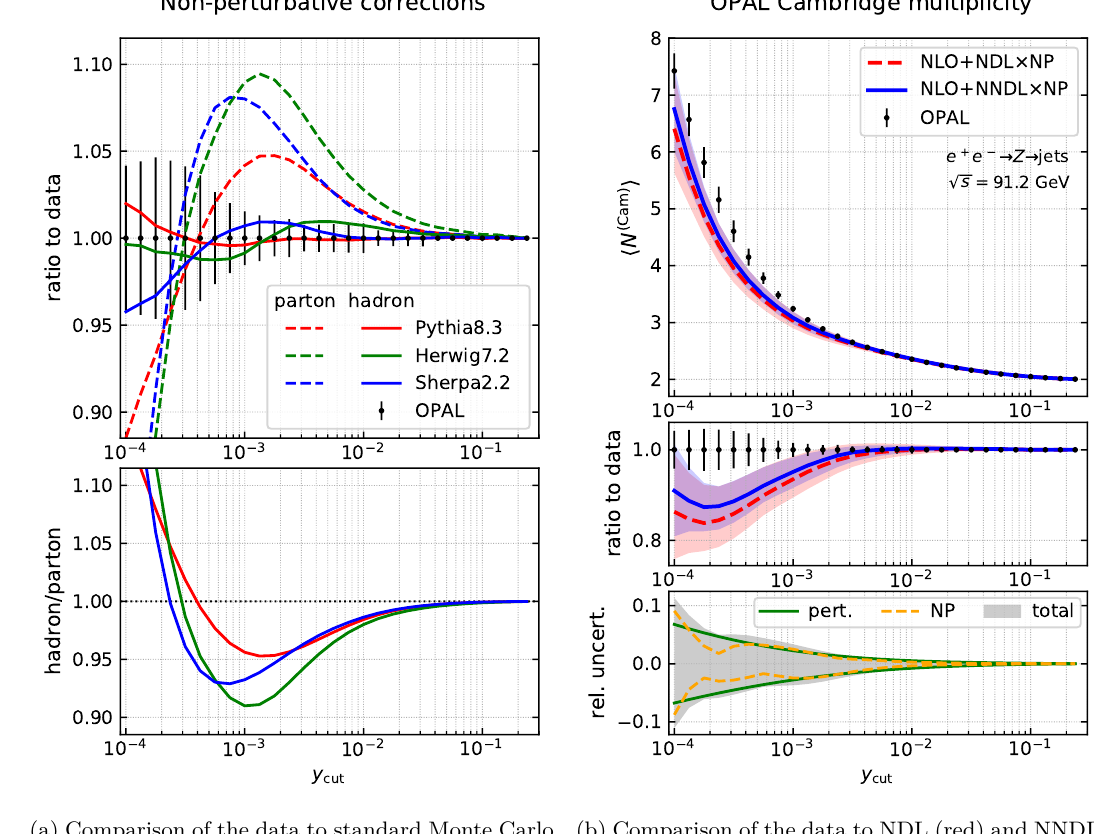
(a) Comparison of the data to standard Monte Carlo (b) Comparison of the data to NDL (red) and NNDL generators at parton (dashed) and hadron (solid) (blue) resummed results matched to NLO and cor- levels. rected for non-perturbative effects. Figure 9. Comparison of Monte Carlo (left) and analytic (right) results to the existing average Cambridge jet multiplicity measurement [45] from the OPAL collaboration at